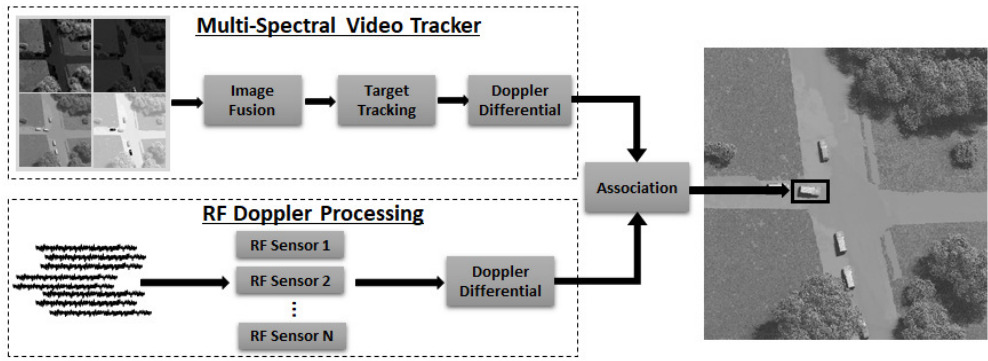
Figure 3. Flowchart of the fusion processing to associate a specific moving target between a multi-spectral video tracker and a constellation of RF sensors.